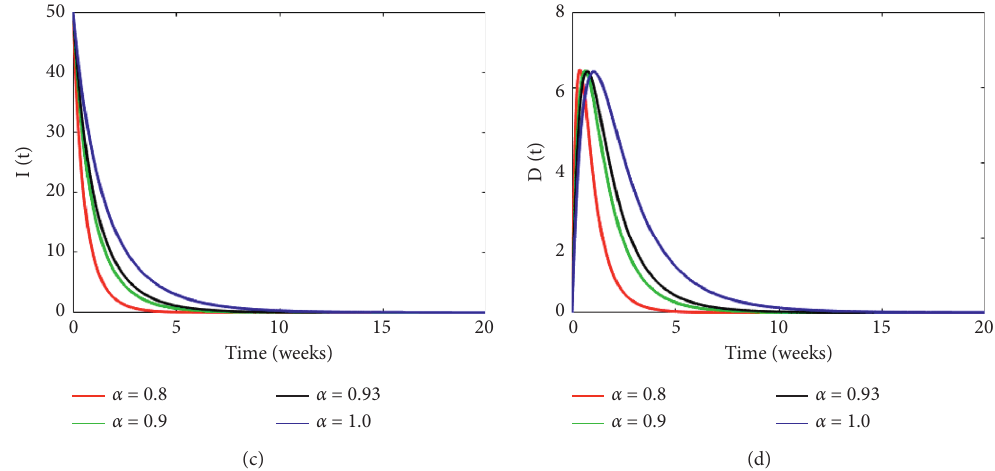
Figure 5: Dynamical solutions of model (8) for different fractional-order values. The initial population levels were assumed as follows: S ( 0 ) � 6900, E ( 0 ) � 100, I ( 0 ) � 50, and D ( 0 ) � 0. We set β � 0 . Table 2, leading to R 0